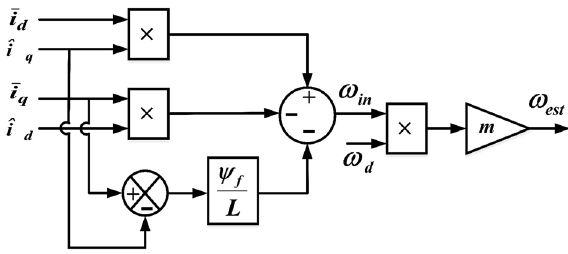
Figure 3. Schematic diagram of the proposed sensorless corrector.